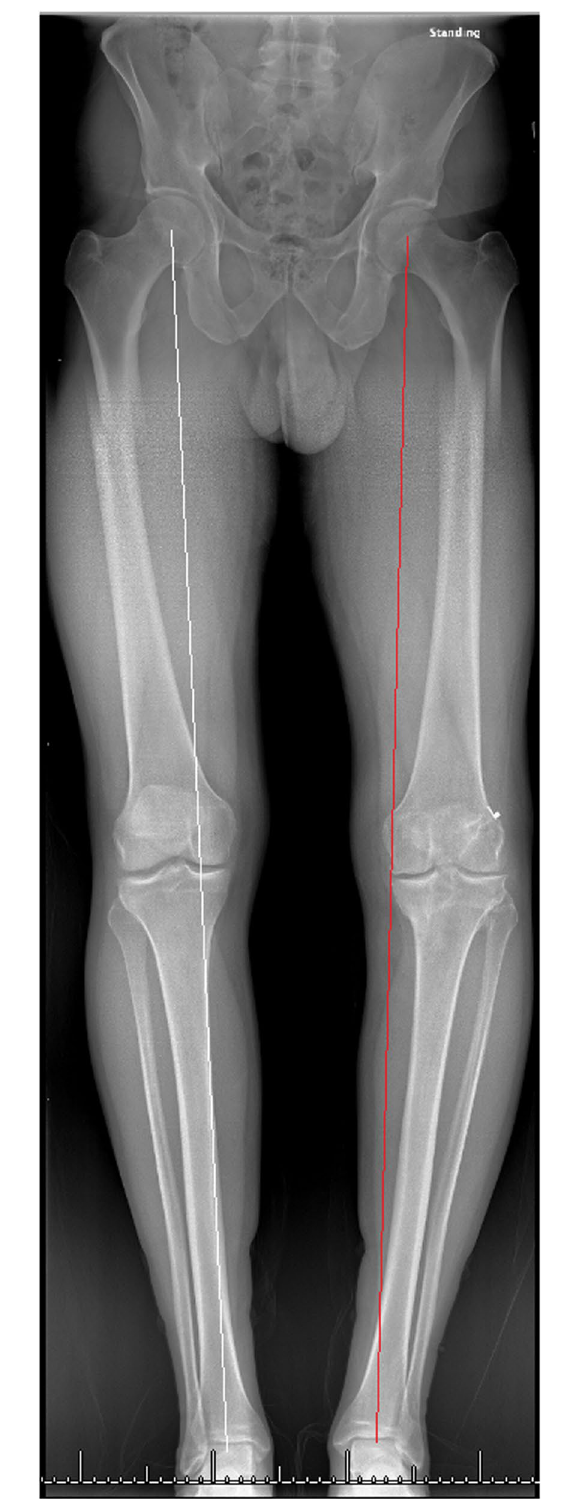
Fig. 13 Standing mechanical axis radiograph showing a healed osteotomy without further varus